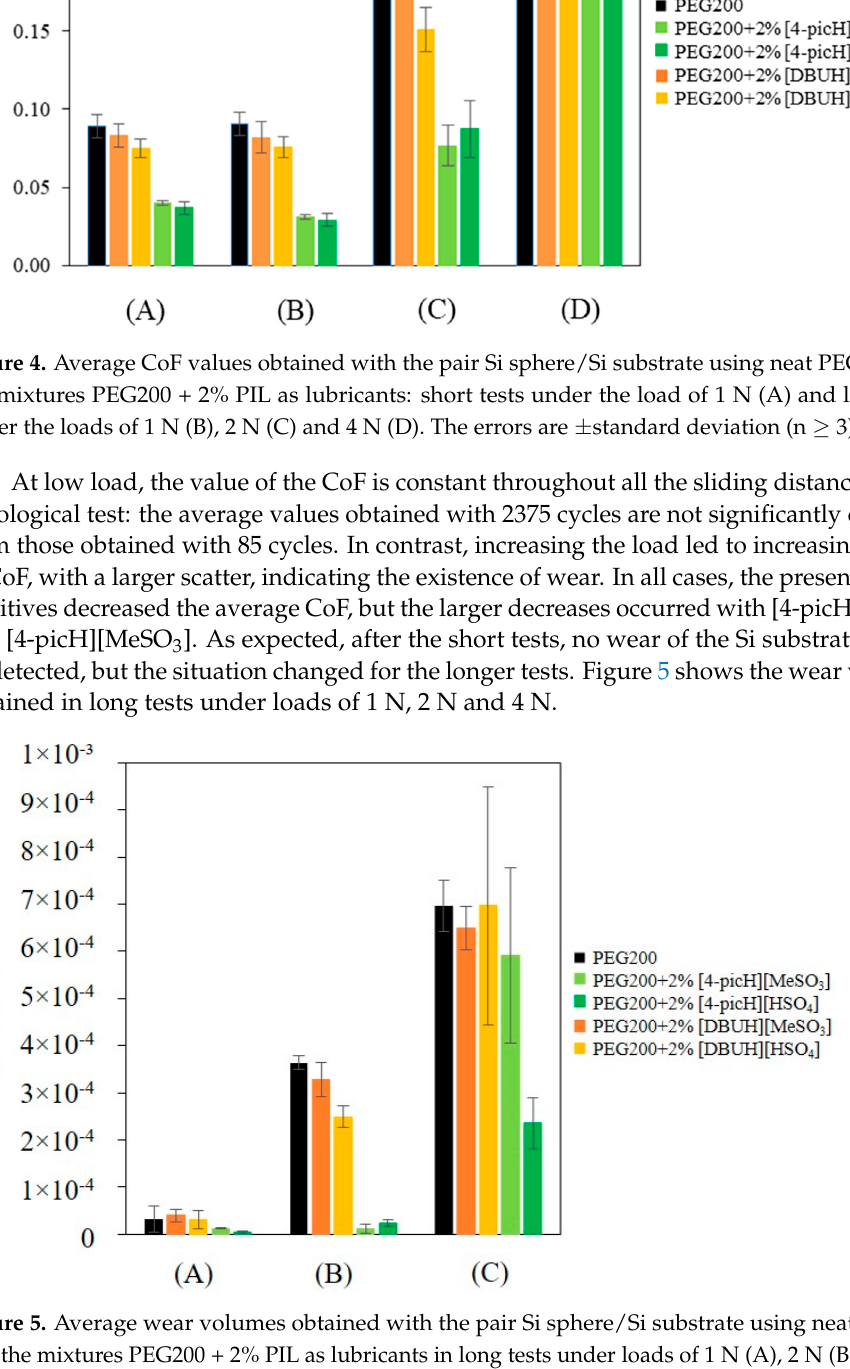
Figure 5. Average wear volumes obtained with the pair Si sphere/Si substrate using neat PEG200 and the mixtures PEG200 + 2% PIL as lubricants in long tests under loads of 1 N (A), 2 N (B) and 4 N (C). The errors are ±standard deviation (n ≥ 3).